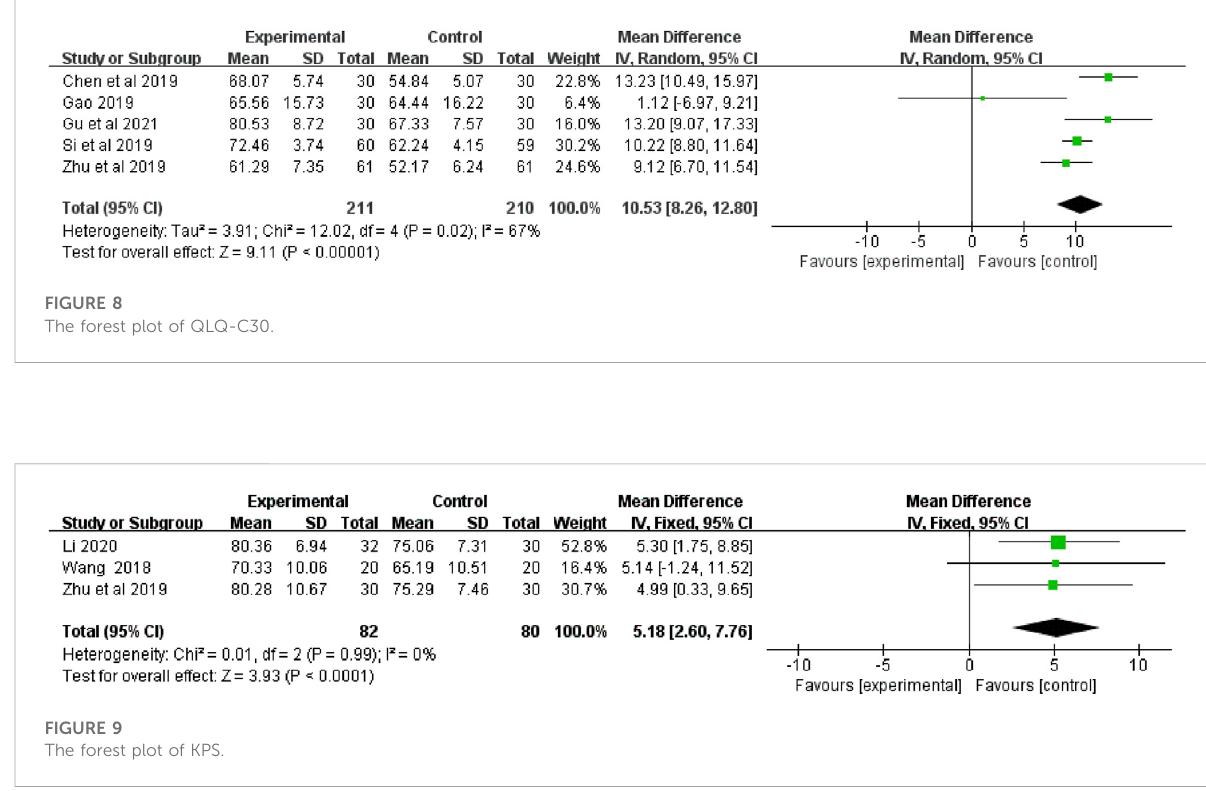
FIGURE 9 The forest plot of KPS.